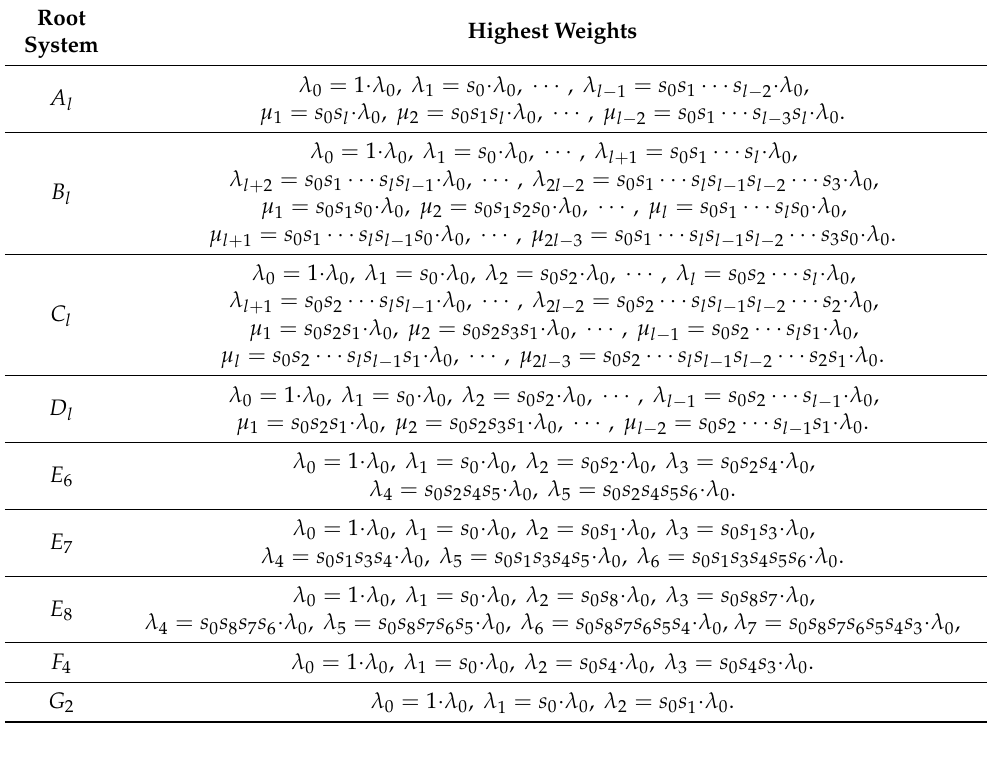
Table 1. Description of the highest weights by the generators of W p